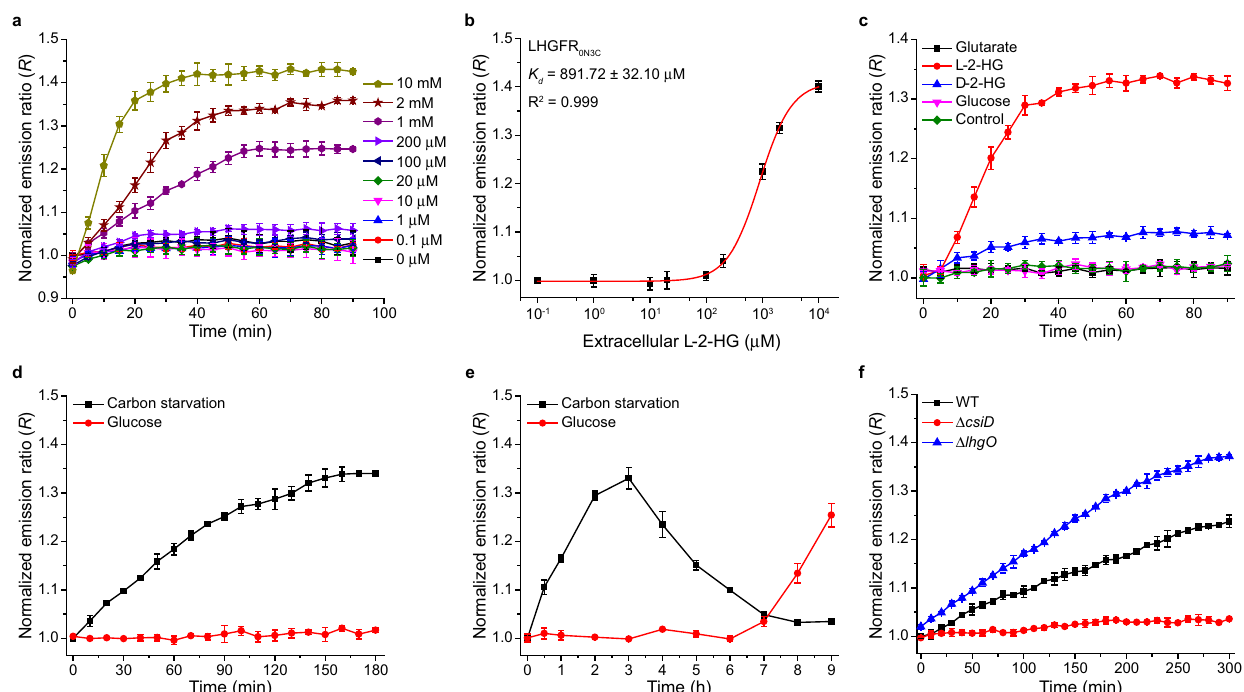
Fig. 5 Monitoring L -2-HG fl uctuations in living bacteria by LHGFR 0N3C . a Time course of the emission ratio changes of LHGFR 0N3C expressed in E. coli BL21(DE3) in response to exogenous L -2-HG addition. All ratios were normalized to the control (ratio in the absence of L -2-HG at time point zero). b Normalized dose-response curve of LHGFR 0N3C expressed in E. coli BL21(DE3) for increasing concentrations (100 nM to 10 mM) of L -2-HG at time point 60 min. c Time course of the emission ratio changes of LHGFR 0N3C expressed in E. coli BL21(DE3) in response to the addition of 1 mM glutarate, L -2-HG, D -2-HG, or glucose. All data were normalized to the control (ratio in the absence of any tested compounds at time point zero). d Detection of carbon starvation-induced L -2-HG accumulation over time by LHGFR 0N3C expressed in E. coli BL21(DE3). Emission ratio changes of LHGFR 0N3C were measured when cultured in carbon starvation medium (black line) and medium with 20 mM glucose (red line). All data were normalized to samples under carbon starvation conditions at time point zero. e Long-term detection of L -2-HG fl uctuations by LHGFR 0N3C expressed in E. coli BL21(DE3). All data were normalized to samples under carbon starvation conditions at time point zero. f Identi fi cation of the roles of CsiD and LhgO in endogenous L -2-HG metabolism during carbon starvation by LHGFR 0N3C . Emission ratio changes of LHGFR 0N3C expressed in E. coli MG1655(DE3) wild-type (black line), E. coli MG1655(DE3) ( Δ csiD ) (red line), and E. coli MG1655(DE3) ( Δ lhgO ) (blue line) were measured in carbon starvation medium. All data were normalized to time point zero of the wild-type strain. Inconsistent initial emission ratios were detected in bacterial cells under different conditions. The normalized emission ratios were thus used to monitor the changes of L -2-HG in different bacterial cells. All data shown are means ± s.d. ( n = 3 independent